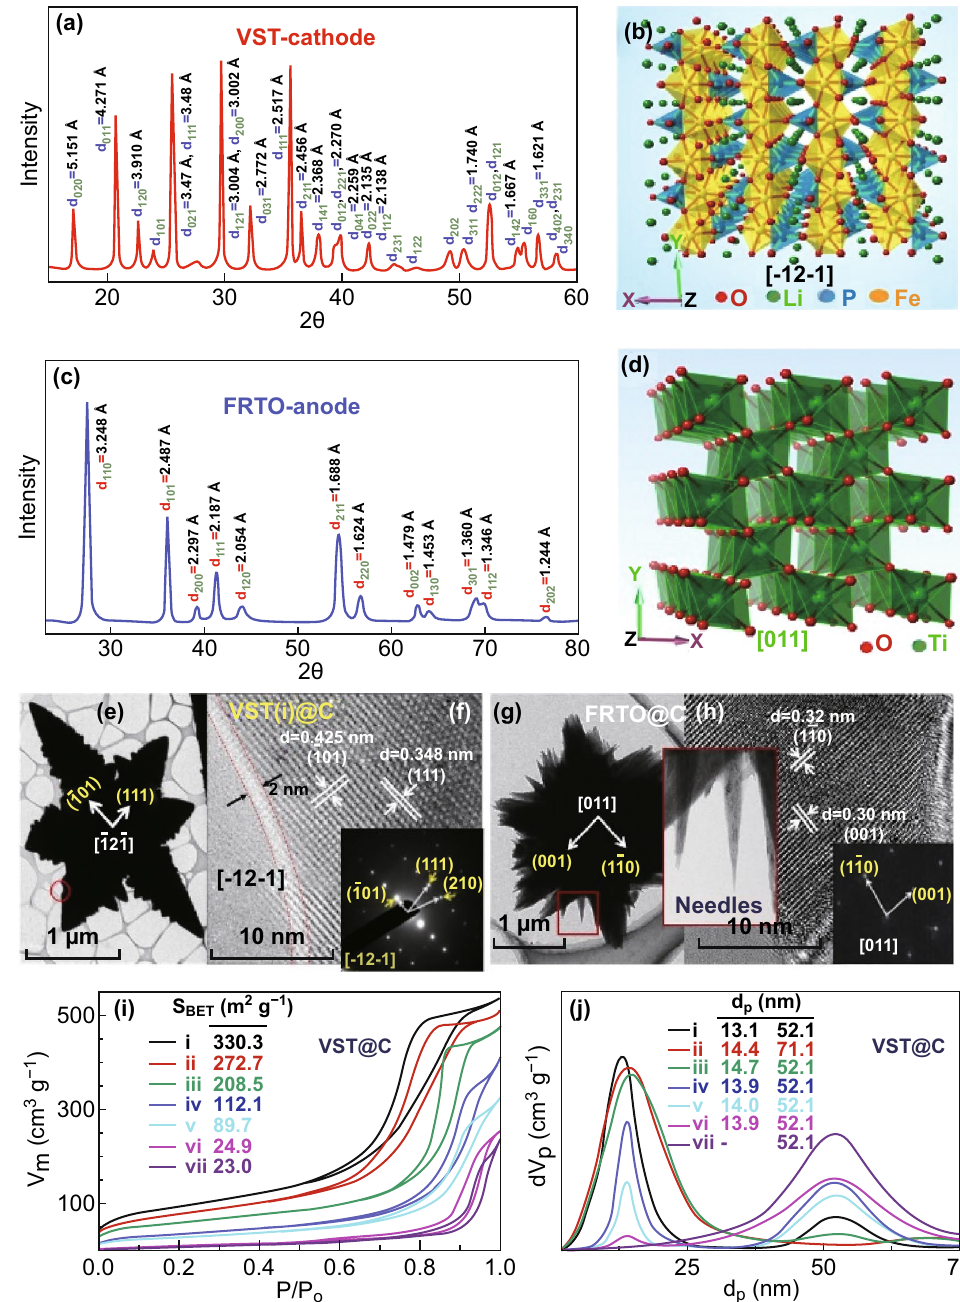
Fig. 2 a , c XRD patterns of the VST‑(i) cathode and FRTO anode hierarchy. b , d Crystal orientation VST cathode with orthorhom‑ bic‑[− 12 − 1]‑LFPO and the FRTO anode with rutile [011]‑TiO 2 structures. e , g Top view, low magnification HR‑TEM micrographs of the